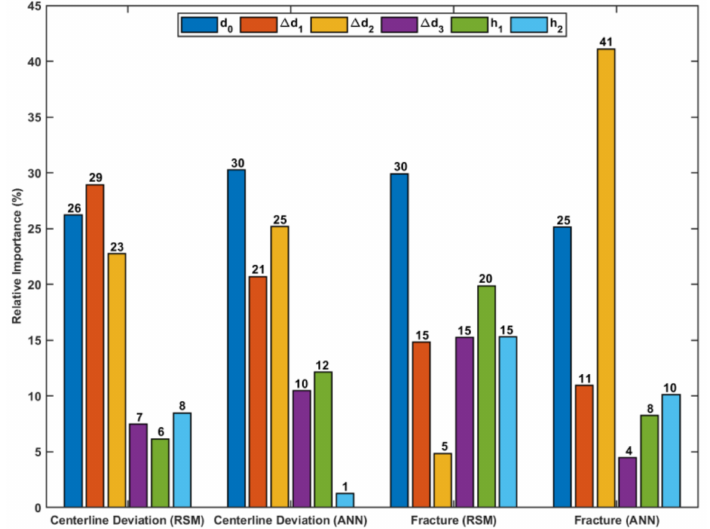
Figure 18. The relative importance of variables on objective functions.